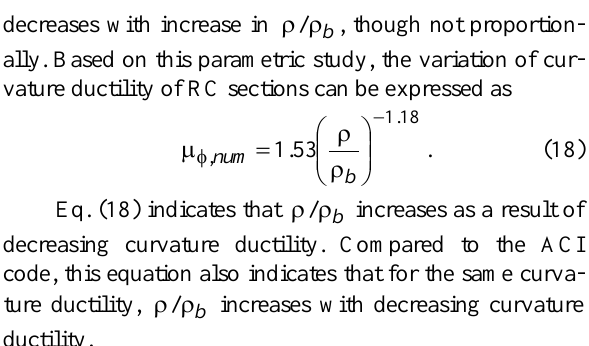
f on the ratio of curvature ductility to c